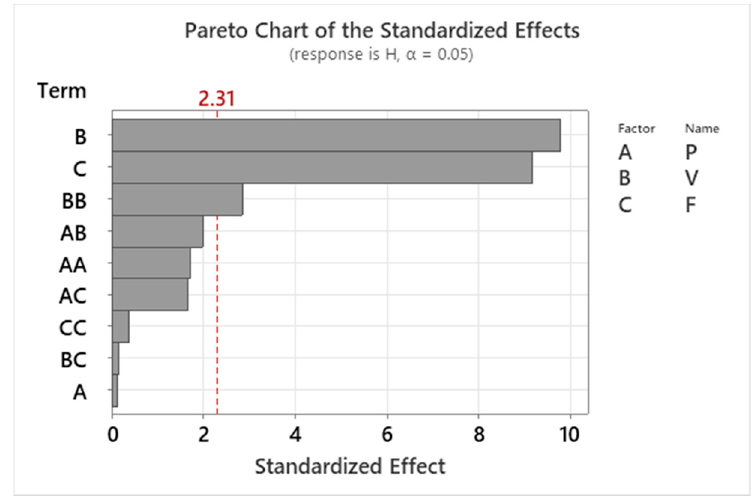
Figure 6. Pareto chart (significance level, α = 0.05) of the standardized effects of process parameters on H .